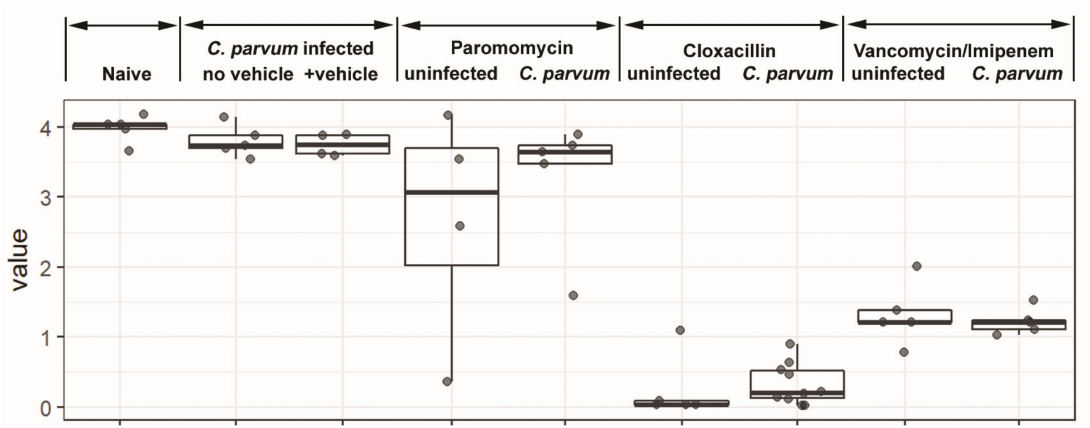
Figure 3. Box-plot comparisons of bacterial diversity and species richness. Bacterial diversity of the di ff erent groups using Shannon’s alpha index. The top and the bottom boundaries of each box represent the 25th and 75th quartile values. Ends of the whisker box mark the lowest and highest diversity values in each group. Cloxacillin- and vancomycin / imipenem-treated mice had significant decreases ( p < 0.0005) in the Shannon value. The Shannon index was not significantly decreased for paromomycin treated mice vs. vehicle controls ( p > 0.27) or naïve ( p > 0.06) or the untreated C. parvum infected group alone ( p > 0.9) when compared to uninfected or vehicle control mice (determined by analysis of variance